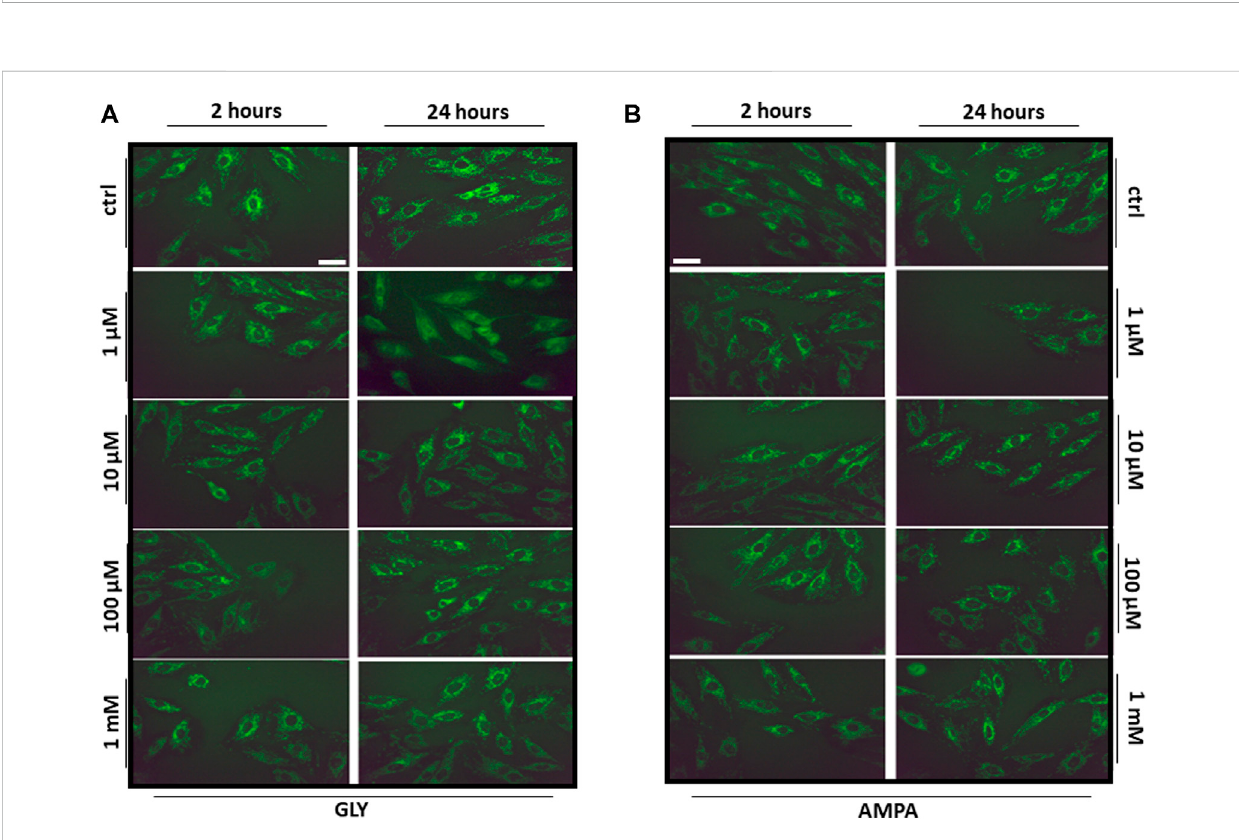
FIGURE 7 Mitochondrial distribution. The fi gure shows the representative images (40X, scale bar = 10 µm) of H9c2 cells stained with the mitochondrial fl uorescent dye MitoTracker Green FM. H9c2 cells were treated with 100 nM to 1 mM of (A) glyphosate (GLY) or (B) AMPA for 2 or 24